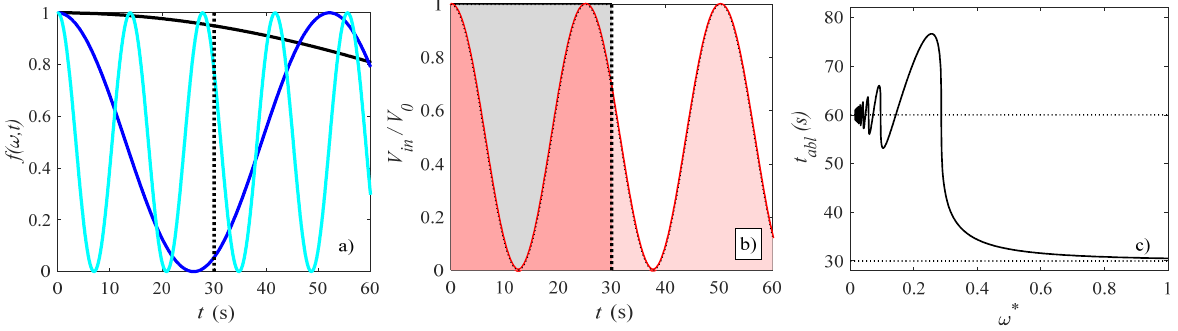
Figure 2. ( a ) different angular frequency functions, where black, blue and light blue lines stand for ω * = 1.000, 0.125, and 0.033, respectively, ( b ) input-to-uniform voltage ratio for ω * = 0.250, where the regions in black and red stand for uniform and pulsed, respectively, and ( c ) solution of Equation (15); the dotted line in ( a ) refers to t abl ( ω * = 1).